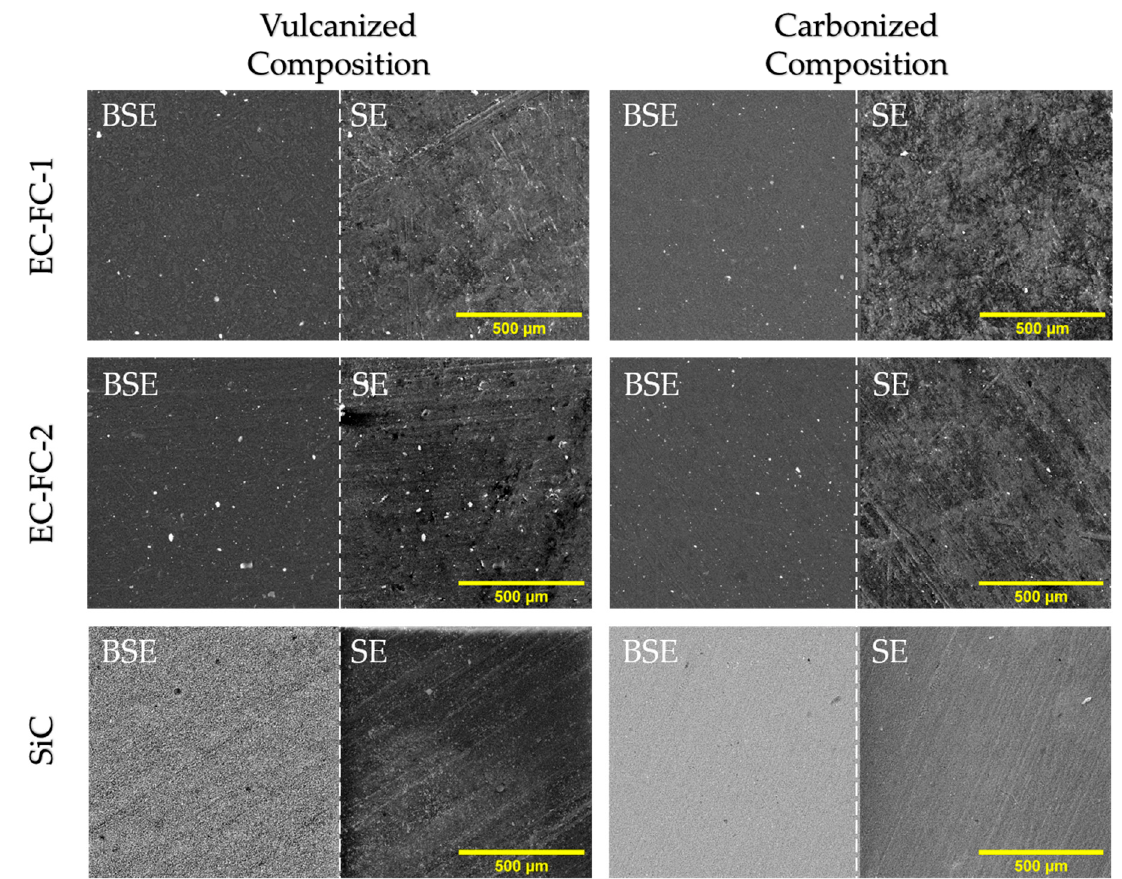
Figure A1. The microstructure of prepared samples with different compositions.